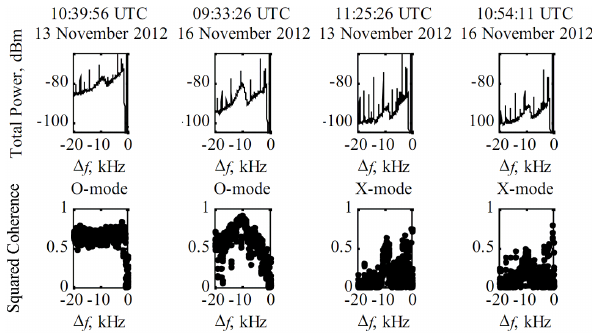
Figure 3. Plots of the total power (top row) and the squared coher- ence (bottom